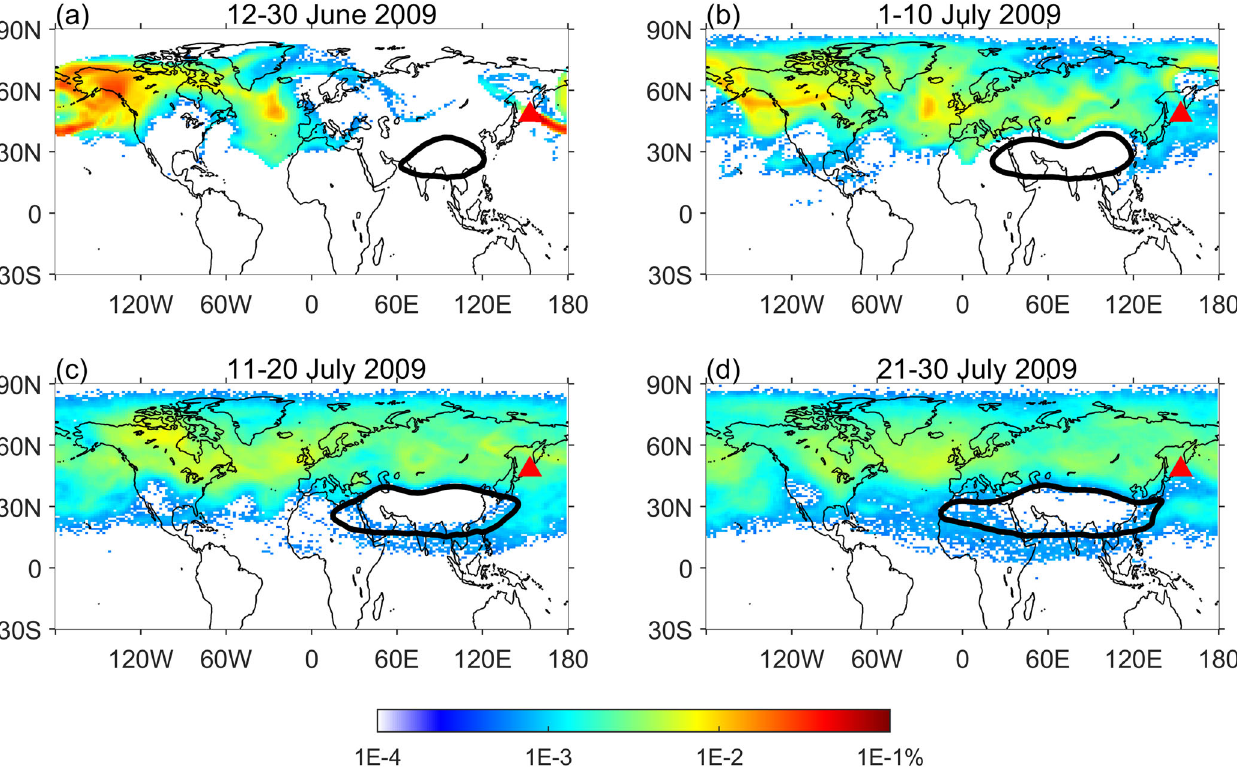
Fig. 3 Percentage (%) of air parcels between isentropic surfaces of 360 – 420 K from MPTRAC simulations for the Sarychev eruption. The percentage of air parcels are shown during a 12 – 30 June 2009, b 1 – 10 July 2009, c 11 – 20 July 2009, and d 21 – 30 July 2009. The bin size is 2° × 1°. The boundary of the ASMA is marked by the 14,320 m geopotential height at the 150 hPa pressure level (thick black contours). The fi lled red triangles indicate the Sarychev